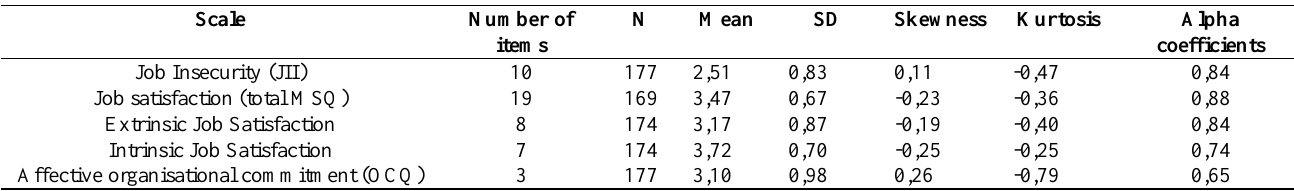
Table 1: Descriptive statistics and Cronbach Alpha coefficients of the various measurements for maintenance workers in a parastatal